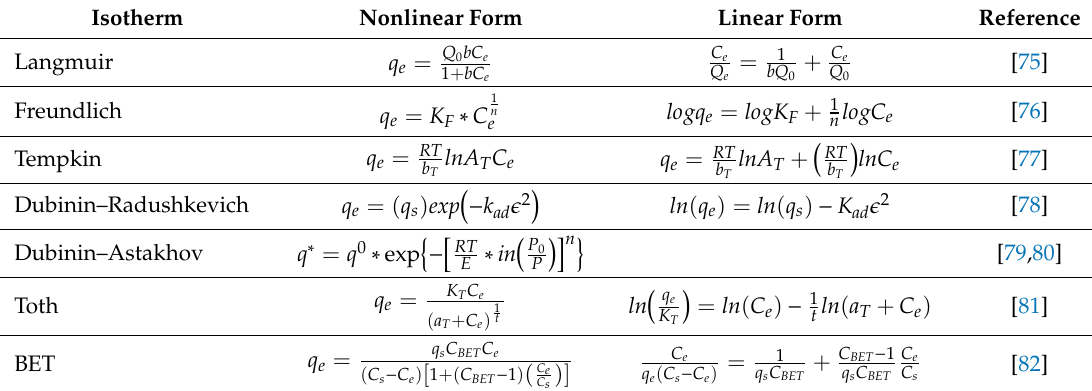
Table 5. Main adsorption isotherm